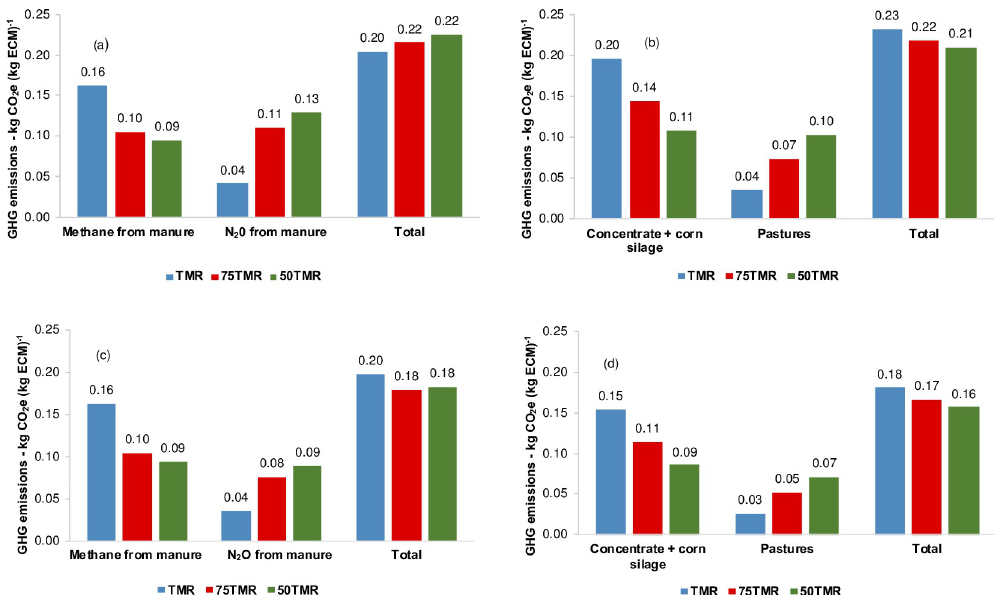
Fig 4. Greenhouse gas emissions (GHG) from manure and feed production in dairy cattle systems. TMR = ad libitum TMR intake, 75TMR = 75% of ad libitum TMR intake with access to pasture, 50TMR = 50% of ad libitum TMR intake with access to pasture. (a) N 2 O emission factors for urine and dung from IPCC [38]. (b) Feed production emission factors from Table 3. (c) N 2 O emission factors for urine and dung from local data [37]. (d) Feed production emission factors from Table 4 accounting sequestered CO 2 -C from perennial